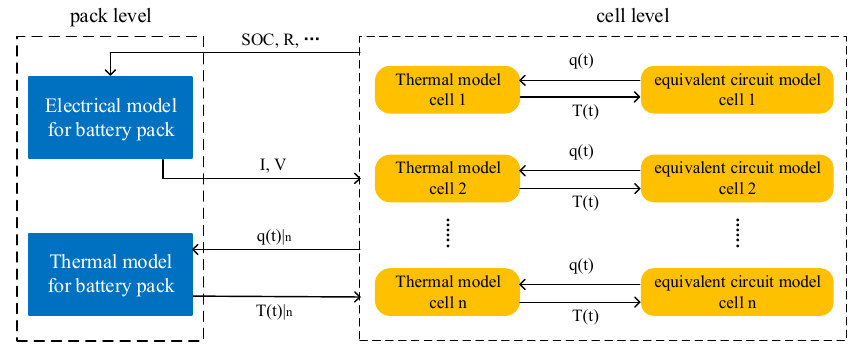
Figure 2. The coupling relationship of the electrothermal model for the battery pack.